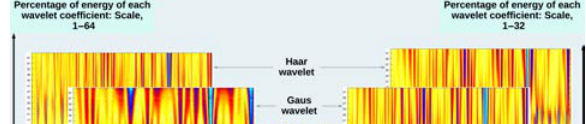
Fig. 12 TSI images of FECG and MECG.